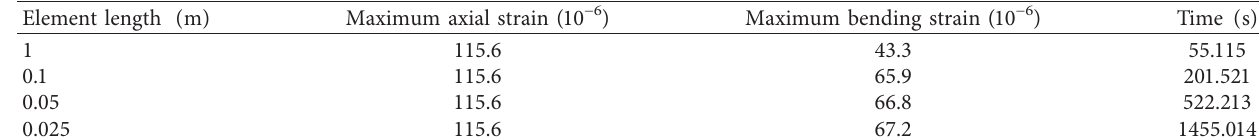
Table 2: Results of different element lengths.